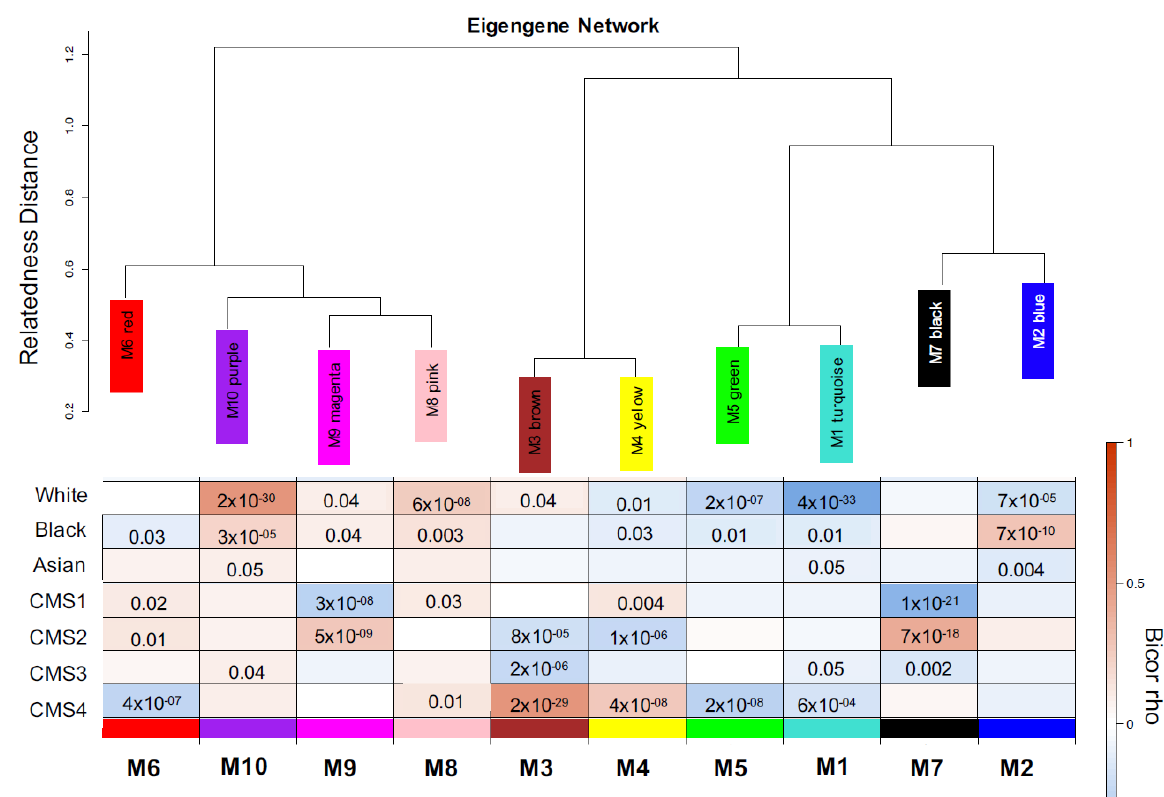
Figure 2. (Top) Hierarchical clustering of module eigengenes that represent modules found after CRC TCGA clustering analysis. Eigengenes positively correlated are grouped together by branches of the dendrogram. (Bottom) Heatmap plot of the adjacencies in the eigengene network including the trait weight. Each row and column in the heatmap correspond to one module eigengene (labeled by color) or weight. In the heatmap, blue color represents low adjacency (negative correlation), while red represents high adjacency (positive correlation).